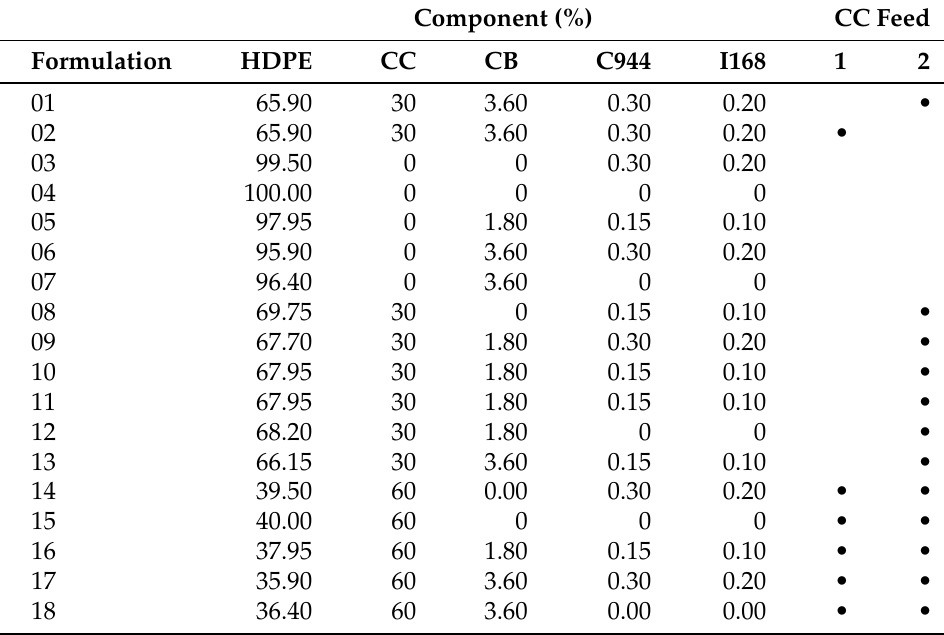
Table 1. Experimental design: formulations and feed points. Reproduced with permission from Viljoen and Labuschagné, Polymer Testing; published by Elsevier, 2020